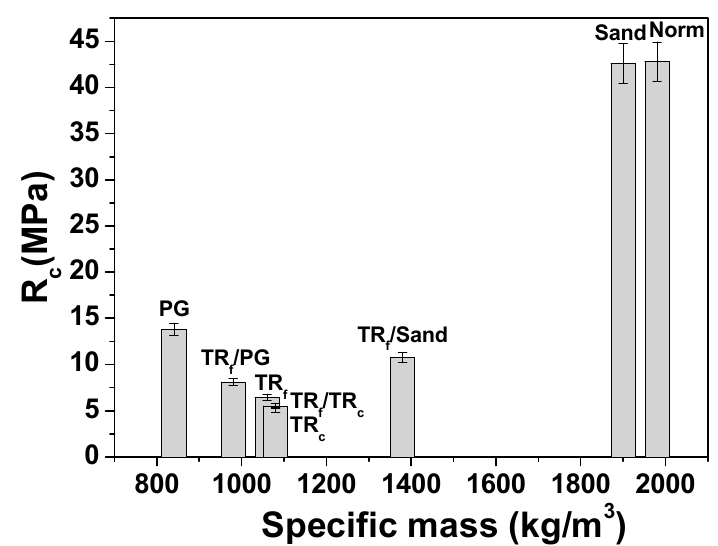
Figure 4. Compressive strengths of the cement mortars.